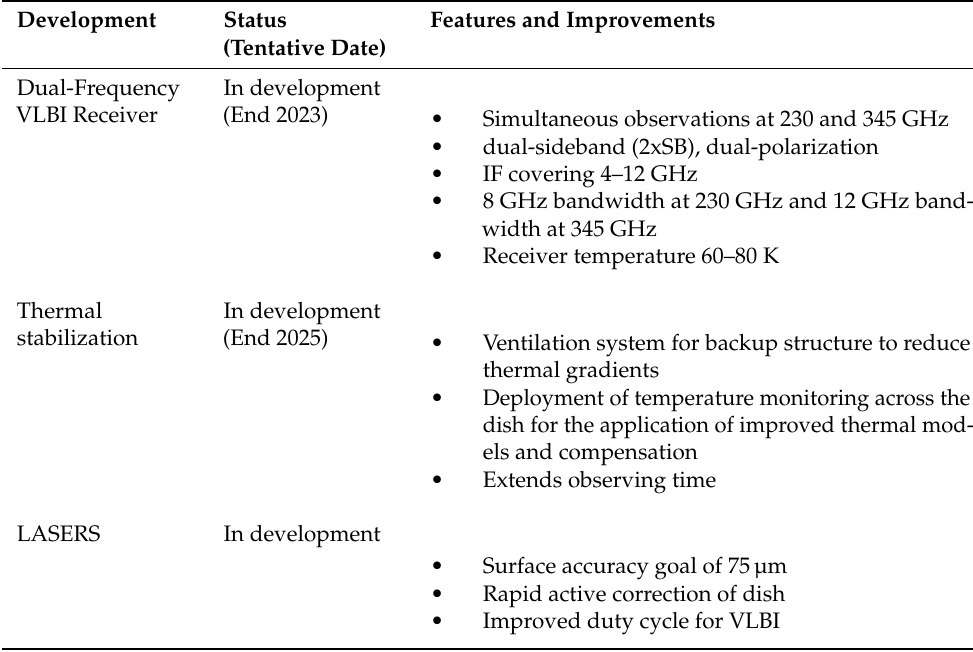
Figure 1. Figure 7 from [22], showing the expected sensitivity at 230 GHz on a VLBI baseline between LMT (and other anchor stations) and a small dish with a 0.5 aperture efficiency in moderate weather (line-of-sight τ = 0.6). The curves demonstrate that baselines to LMT-II should have a sensitivity at 230 GHz to track atmospheric phase on sufficiently short timescales to phase anchor other stations. LMT-II sensitivity includes the full 50 m dish with an assumed aperture efficiency of 0.37. Simultaneous observations at 230 and 345 GHz enabled by a dual-frequency receiver (Section 2.1) at both sites allow for atmospheric phase transfer from 230 GHz to the higher frequency. Table 1. Development Roadmap for LMT upgrades. Key upgrades target improved surface efficiency and stabilization under more varied